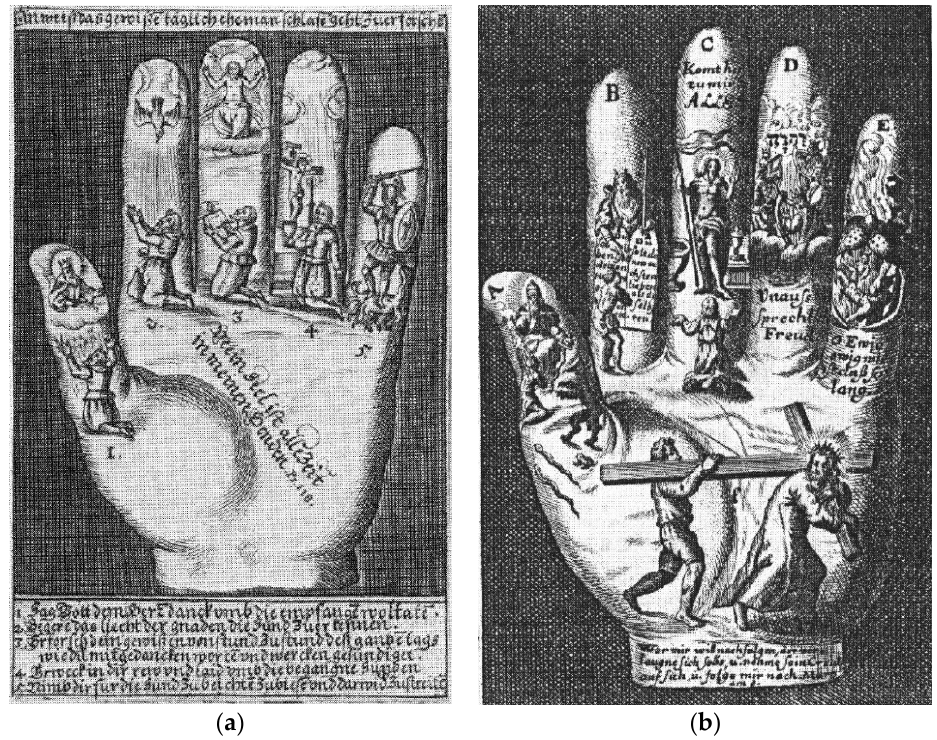
Figure 6. ( a , b ) Post-reformation images of the hand as the Mirror of Salvation. German etchings, mid-Seventeenth Century.